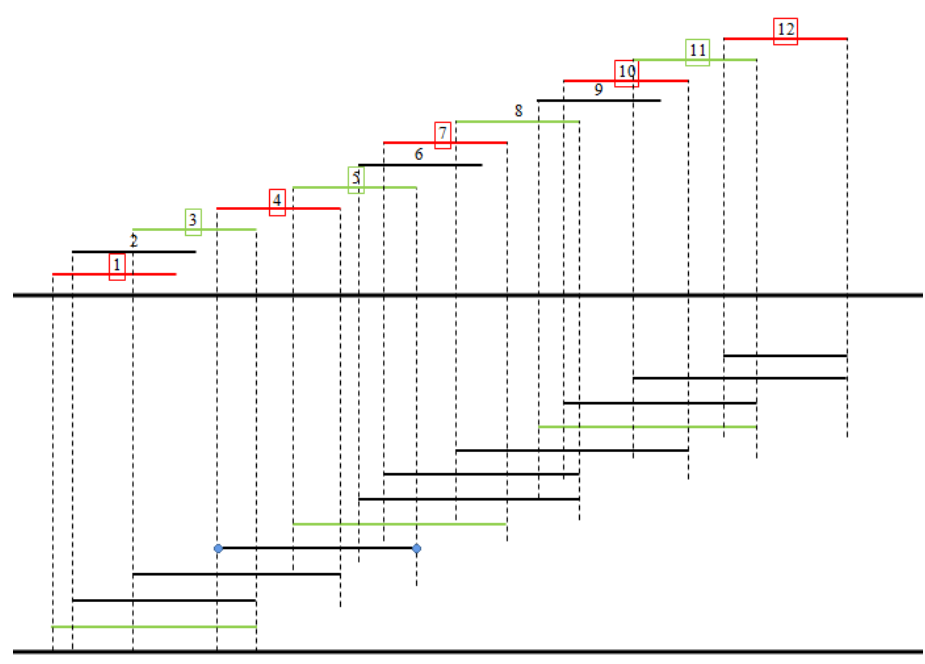
Figure 4. Red intervals form an independent set, and green intervals form an independent dominating